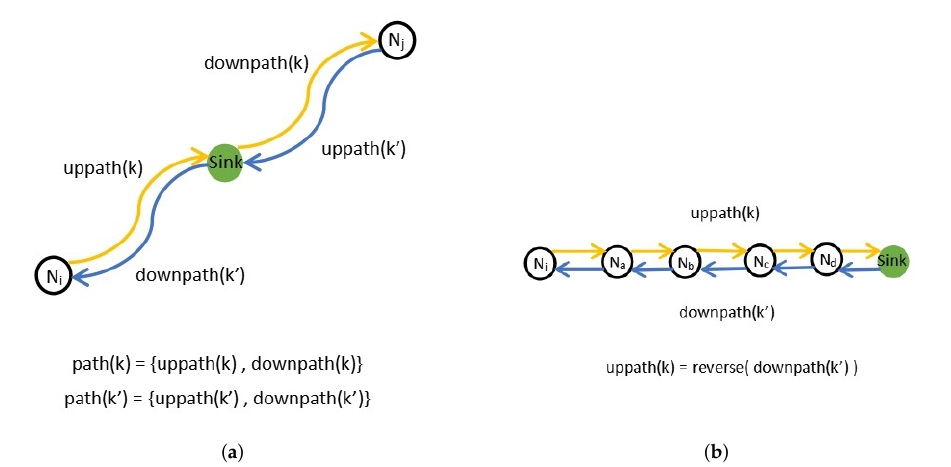
Figure 4. An example of mirrored point-to-point traffic. ( a ) Up-path and downpath. ( b ) Inverse order